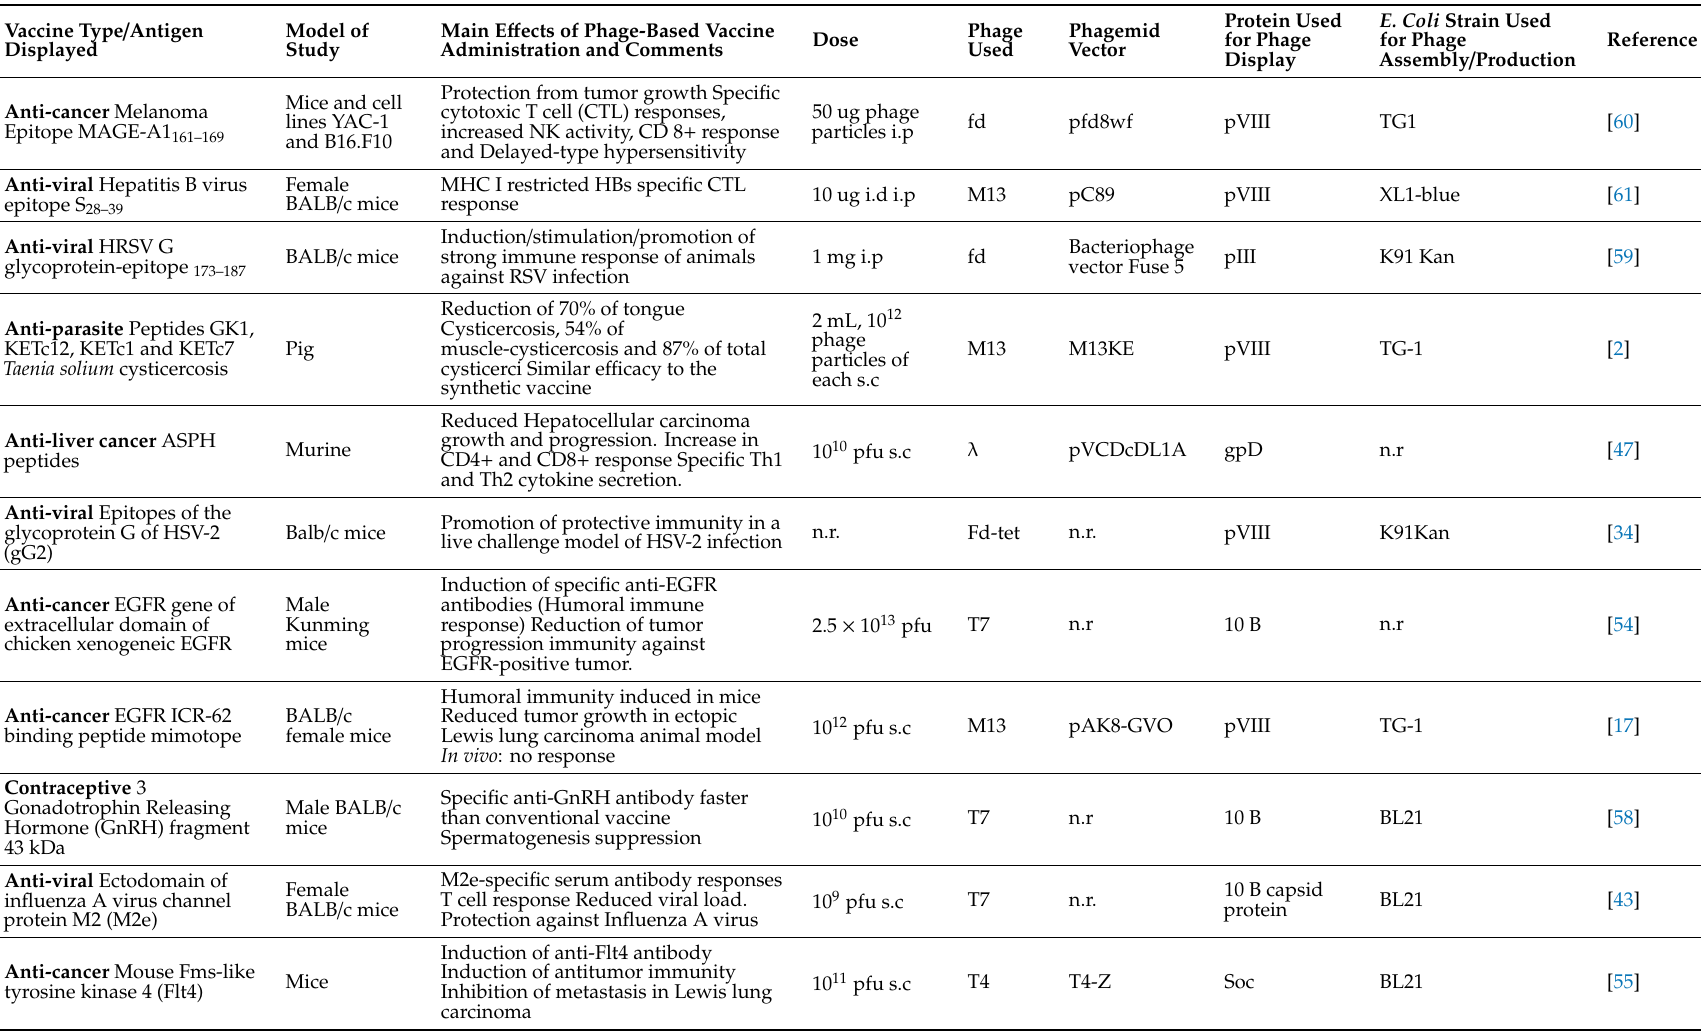
Table 2. Design, characteristics, use and main findings after administration of current bacteriophage-based